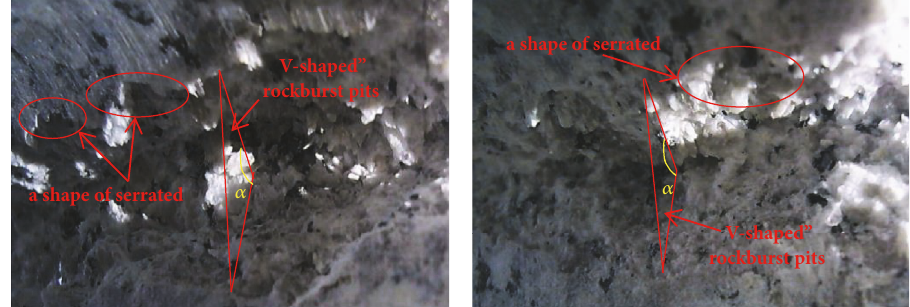
Figure 7: Macroscopic morphology of a rockburst.